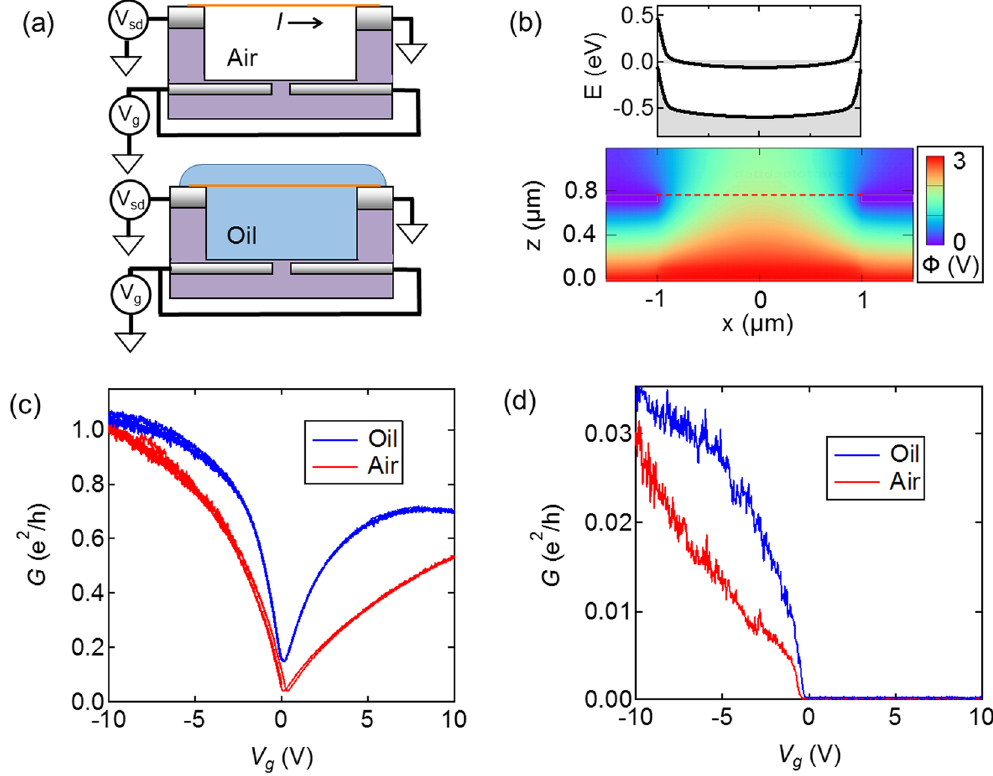
Figure 2. ( a ) Schematic of a CNT field-effect transistor in air and oil environments. ( b ) Self-consistent electrostatics calculation of a wide-gap CNT device with E g = 0.6 eV, V g = 3 V and an air environment. Top: energy band profile along the CNT. Bottom: spatial map of the electrostatic potential Ф( x , z ). ( c ) Conductance of a narrow-gap CNT in air and oil environments. ( d ) Conductance of a wide-gap CNT in air and oil